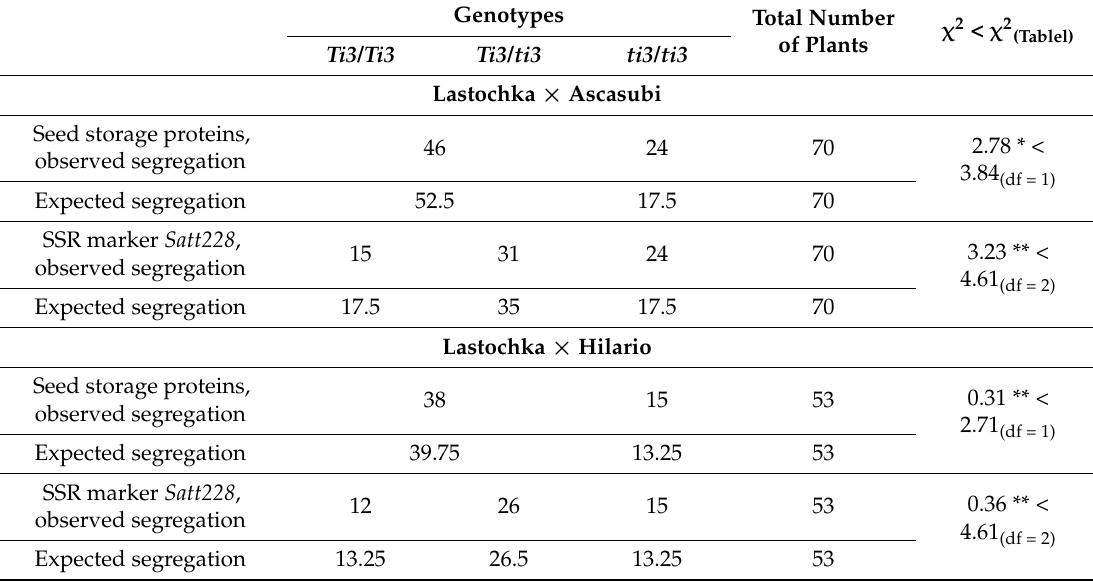
Table 3. Segregation analyses of genotypes of the Ti3 locus using seed storage proteins and the molecular SSR marker Satt228 in F 2 populations of Lastochka × Ascasubi and Lastochka × Hilario. The asterisks (* and **) indicate no significant differences ( p < 0.05 and p < 0.01, respectively) between observed and expected segregations for simple Mendelian ratio (3:1 for seed storage proteins and 1:2:1 for SSR marker Satt228 ), compared to the Chi-square distribution table.